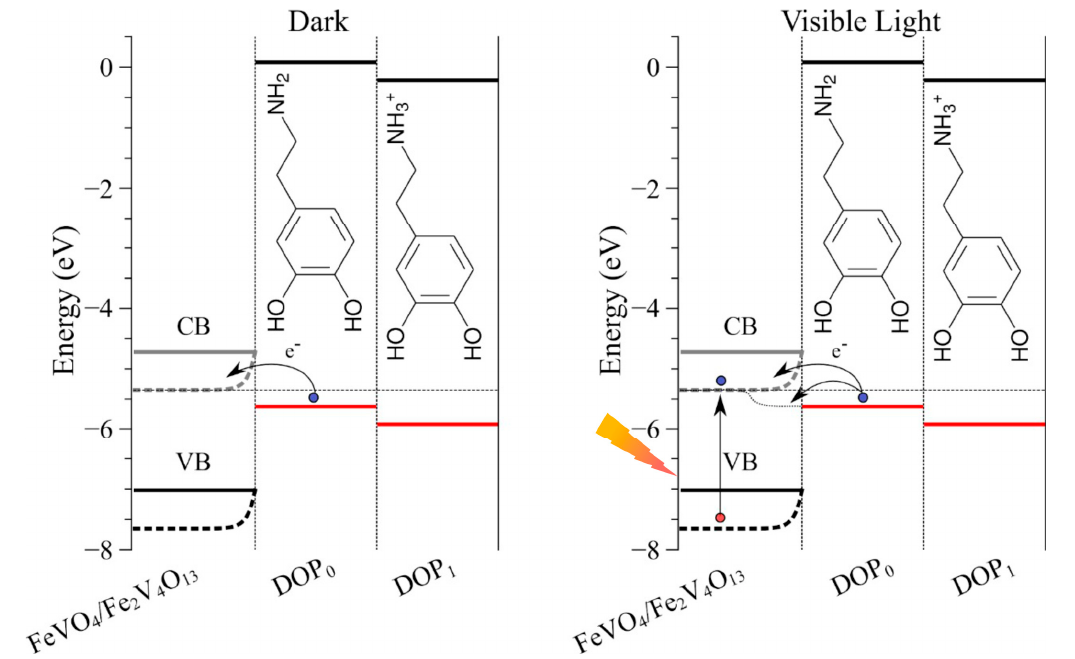
Figure 6. Relative alignment between the frontier electronic levels of electrodes and DOP species and illustration of charge transfer